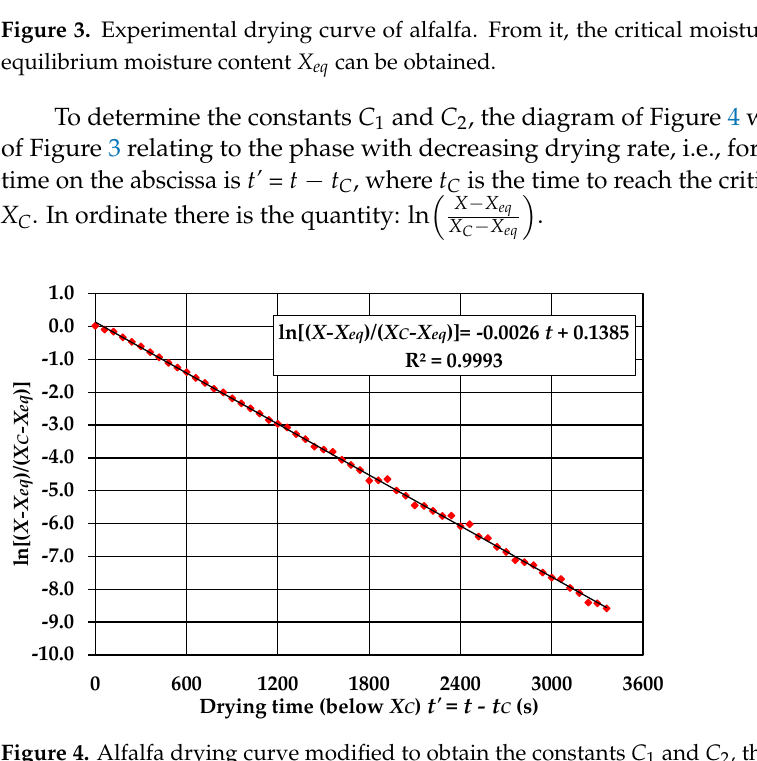
Figure 4. Alfalfa drying curve modified to obtain the constants C 1 and C 2 , the first can be linked to the diffusivity of the water inside the product and to the size, the second to the initial delay.